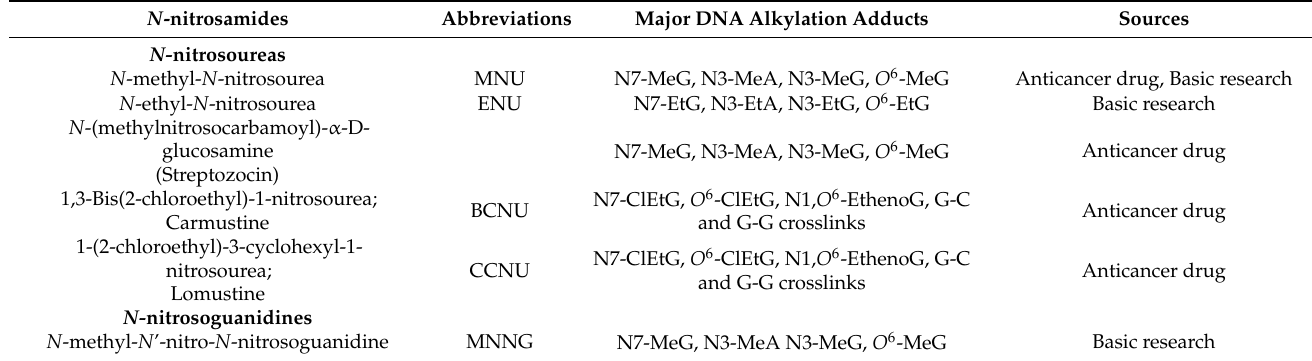
Table 2. Important nitrosamides, DNA alkylation adducts, and their